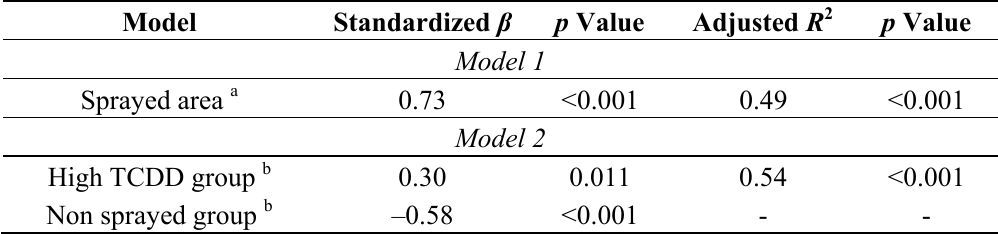
Table 4. Relationship between SCE and regional difference as determined by multiple regression analysis ( n = 63).